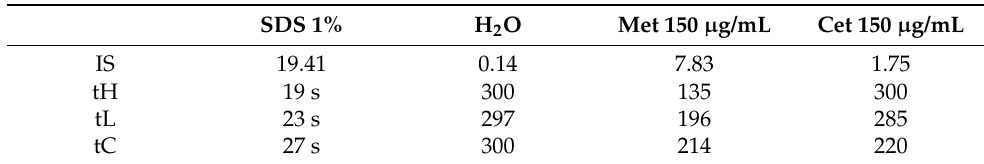
Table 2. Irritation score values for positive control (SDS 1%), negative control (distilled water), Met 150 µg/mL, and Cet 150 µg/mL.